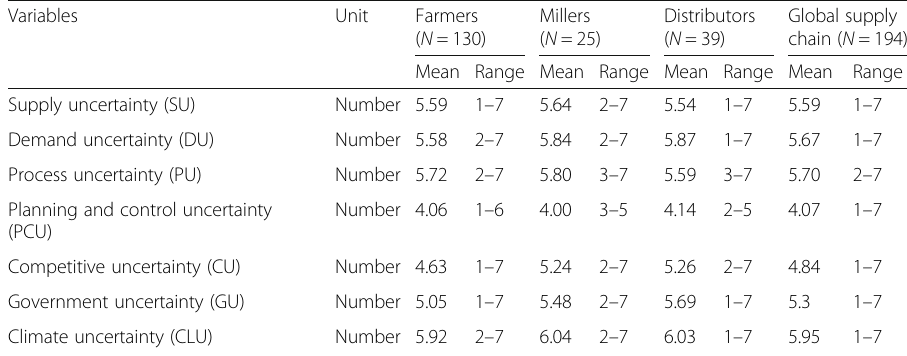
Millers Distributors Global supply ( N = 130) ( N = 25) ( N = 39) chain ( N = 194) Mean Range Mean Range Mean Range Mean Range Number 4.06